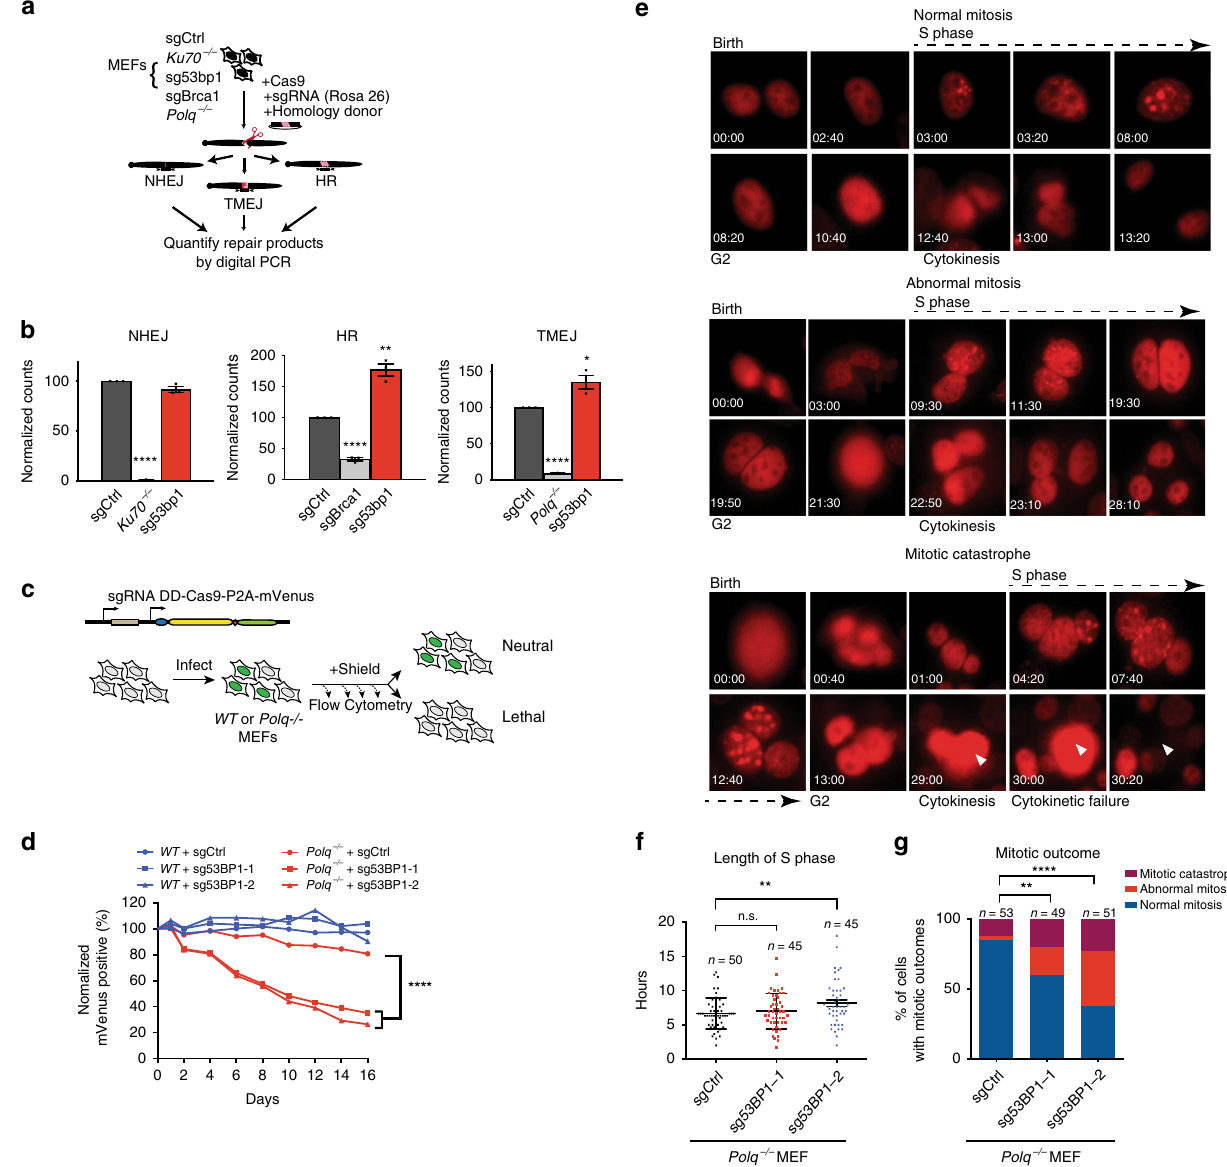
WT + sgCtrl WT + sg53BP1-1 WT + sg53BP1-2